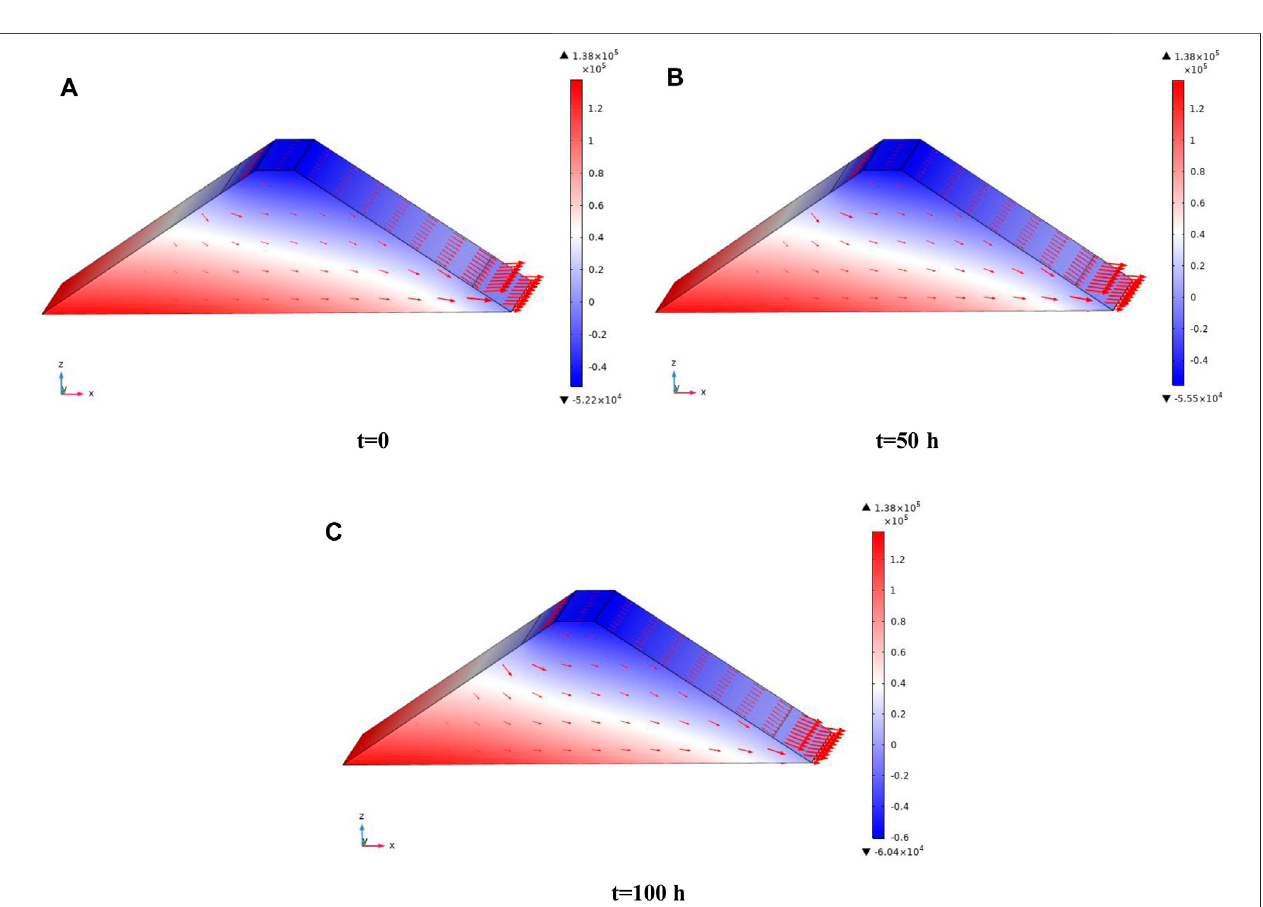
FIGURE 6 | Spatial distribution of the pore water pressure (unit: Pa) and water seepage velocity in the embankment dam slope. (A) t = 0, (B) t = 50 h, and (C) t = 100 h.